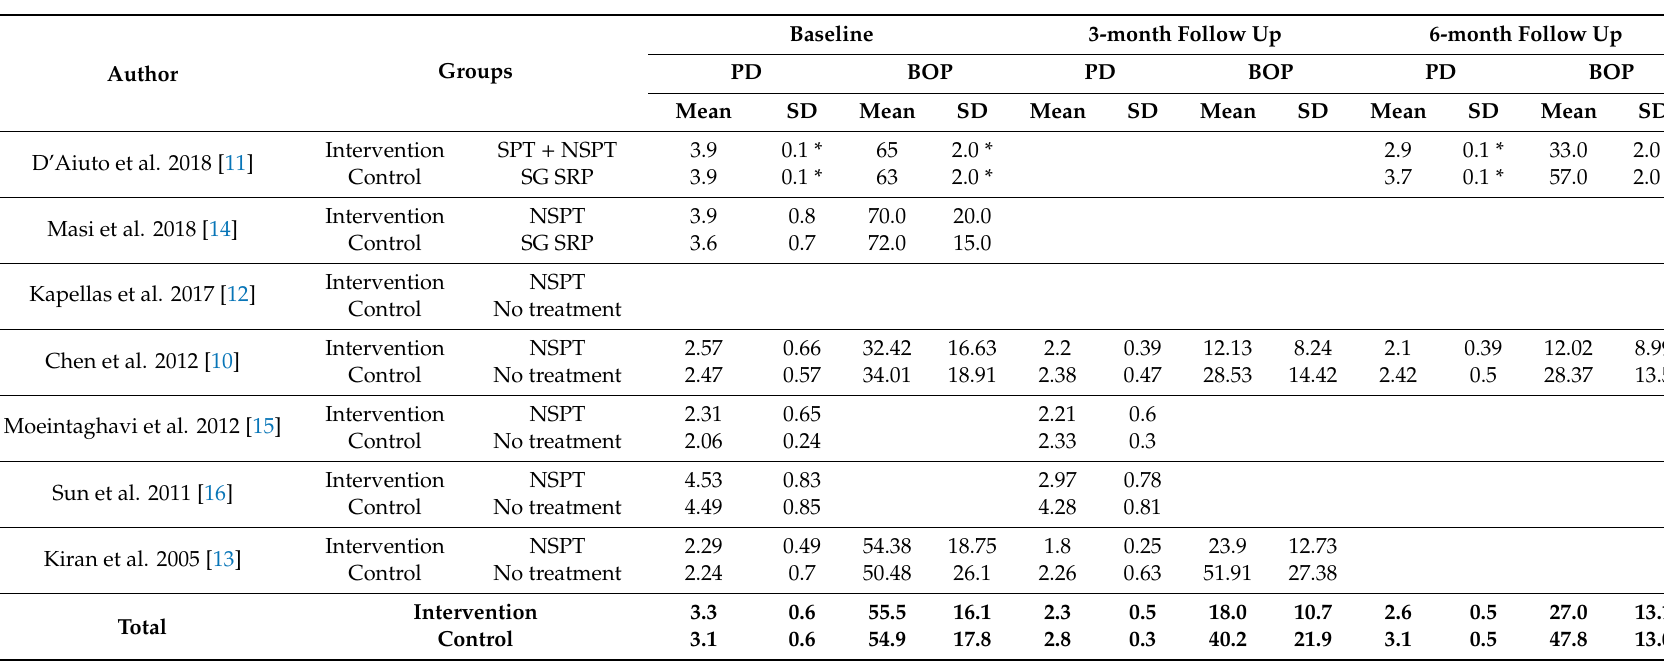
Table 3. Periodontal parameters at baseline, and 3 and 6